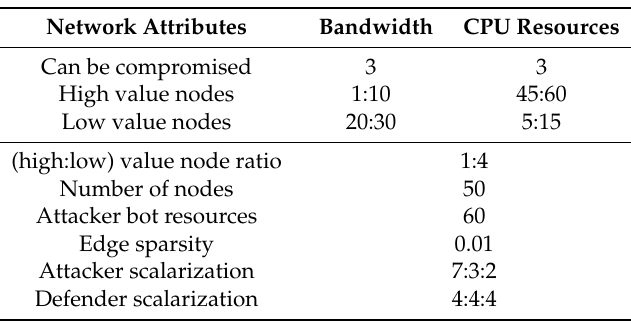
Table 6. Configuration for a simple network.